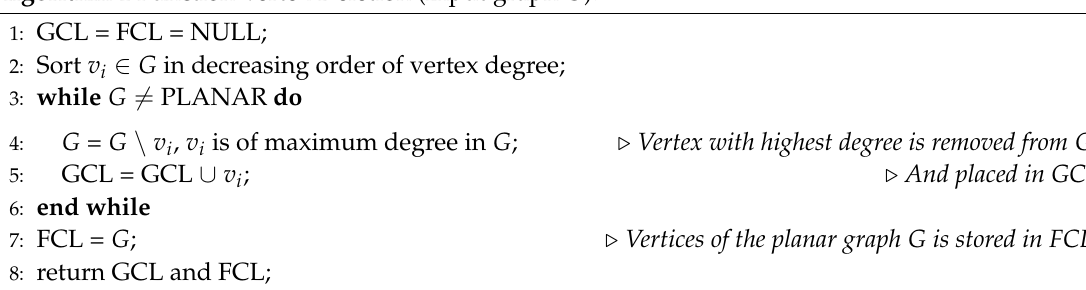
Algorithm 1 Function Vertex Deletion (Input graph G ).